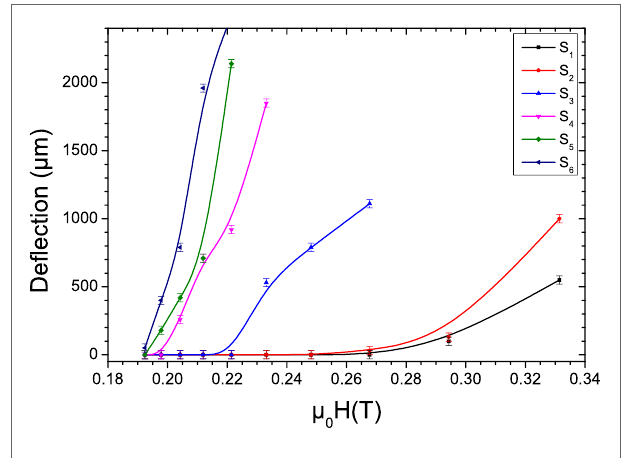
FigUre 8 | Measured deflections as a function of the magnetic actuation for cantilevers fabricated with M-sres s 1 –s 6 .